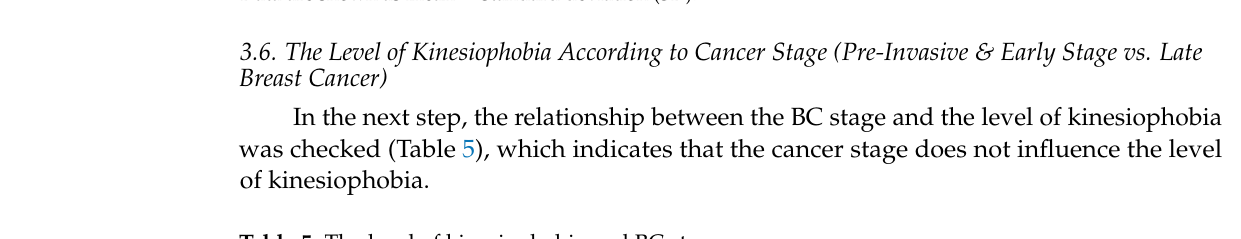
Table 5. The level of kinesiophobia and BC stage.